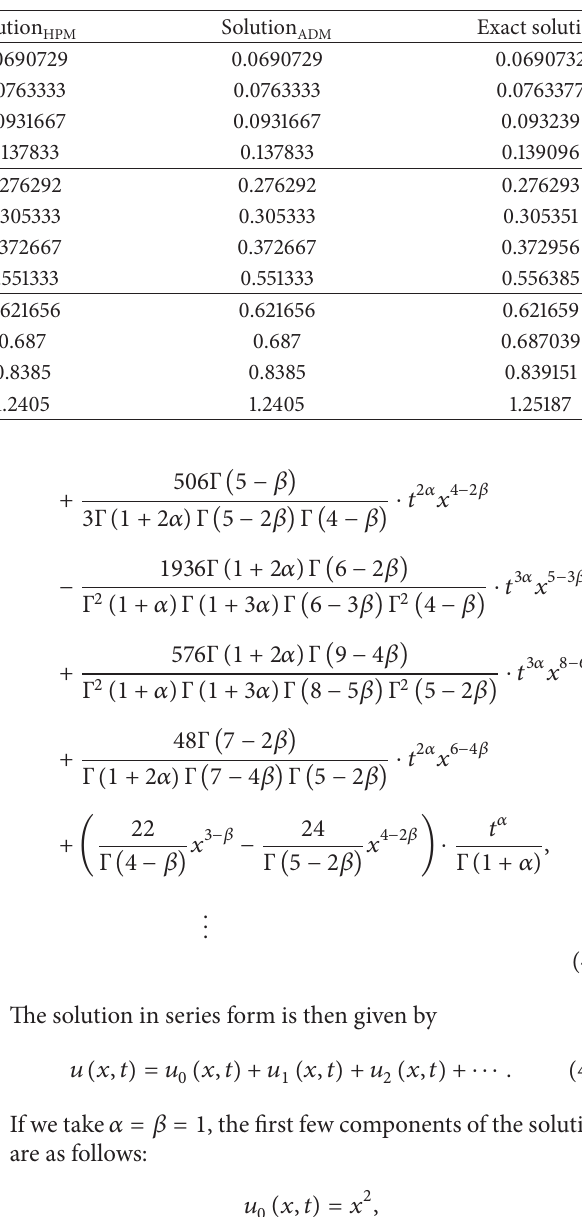
Table 1: Several approximate values and exact solutions for (36) and (37) when 𝛼 = 𝛽 = 1